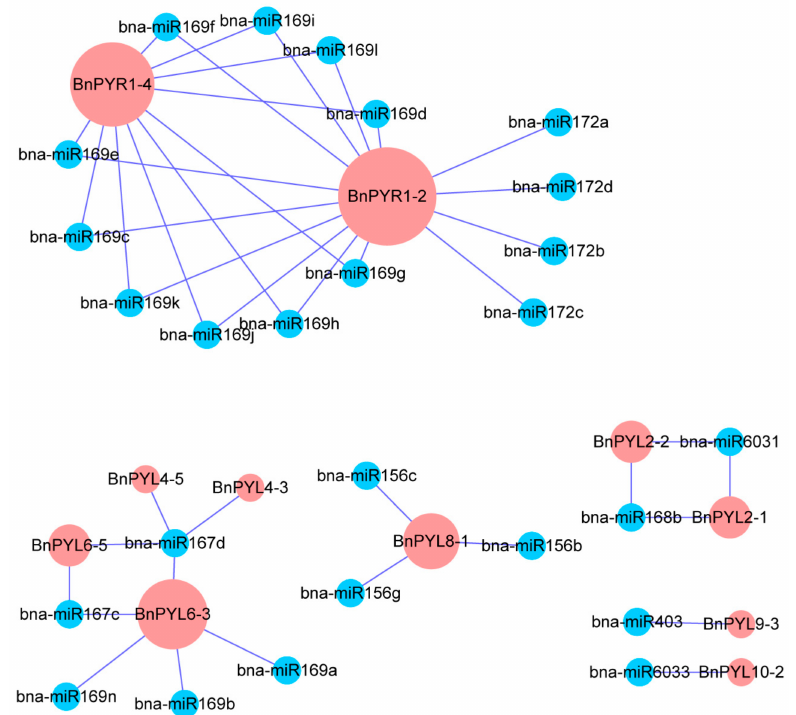
Figure 5. A schematic representation of the regulatory network relationships between the putative miRNAs and their targeted BnPYL